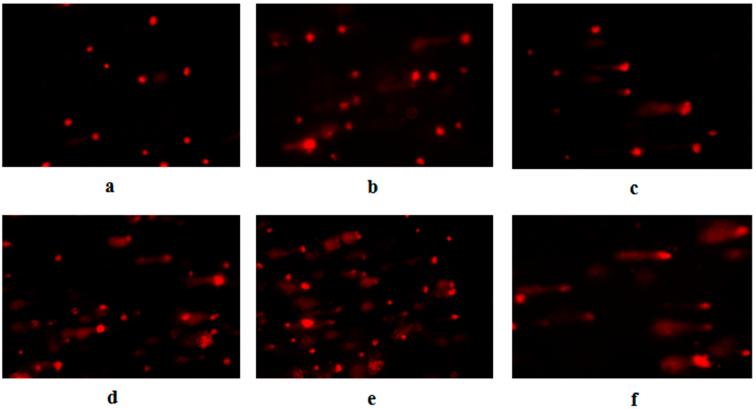
Figure 4. The degree of DNA damage of hepatocytes exposed to aniline for 24 h. ( a ) 0 µ g/mL; ( b ) 2.50 µ g/mL; ( c ) 5.0 µ g/mL; ( d ) 10.0 µ g/mL; ( e ) 10.0 µ g/mL + 20 mmol/L NAC; ( f ) positive control (H 2 O 2 ). (Original magnification 100 ×